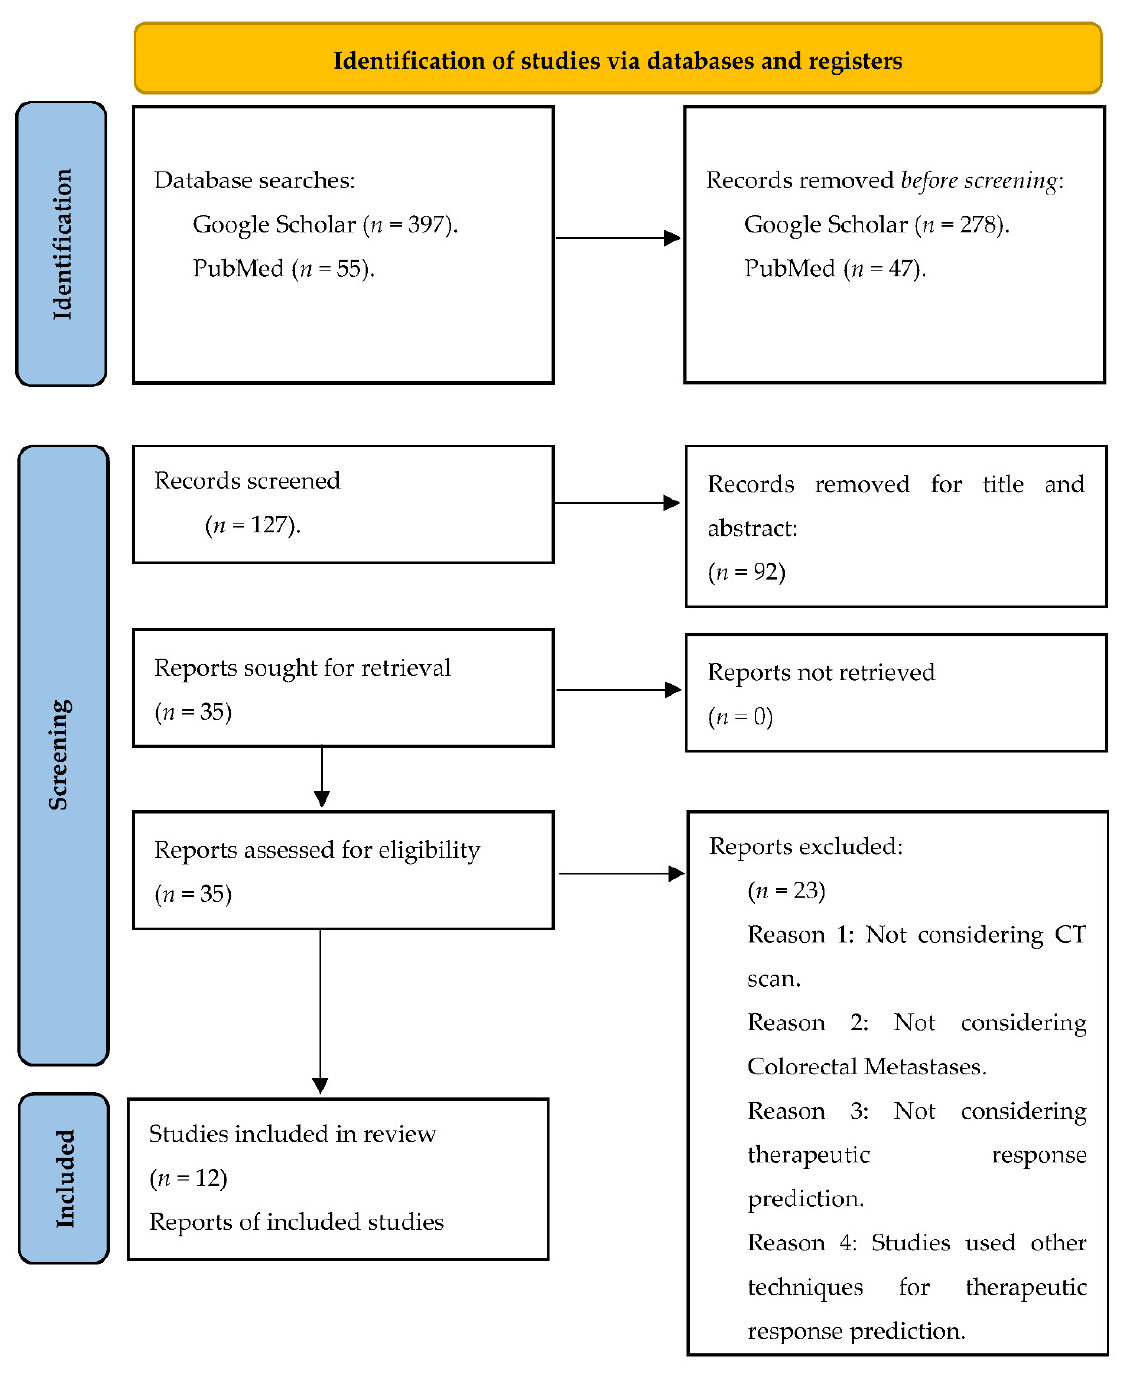
Figure 1. An illustration of the PRISMA flow diagram for a systematic review, including the database searches, abstract screening, and full text retrieval.